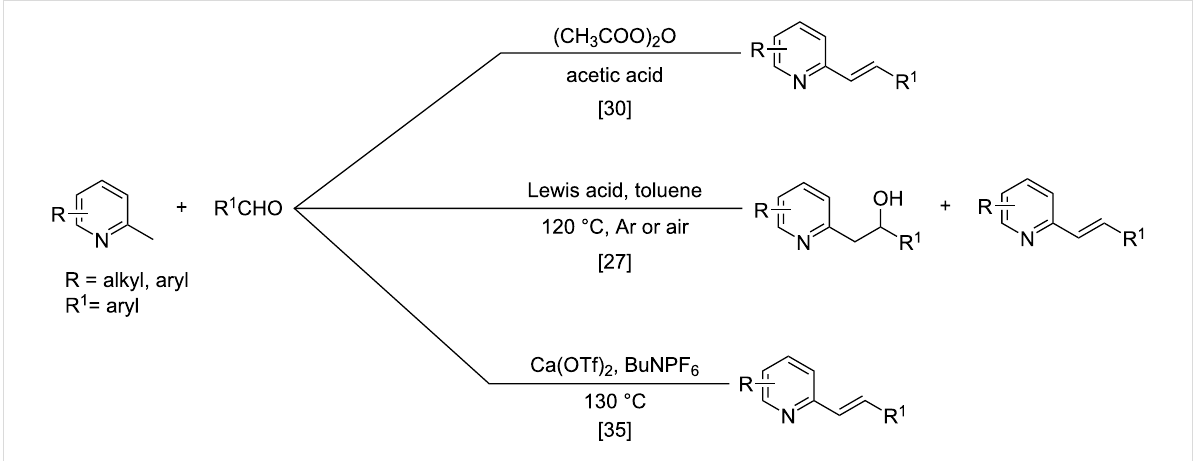
Scheme 1: Benzylic addition of aldehydes to azaarenes using different